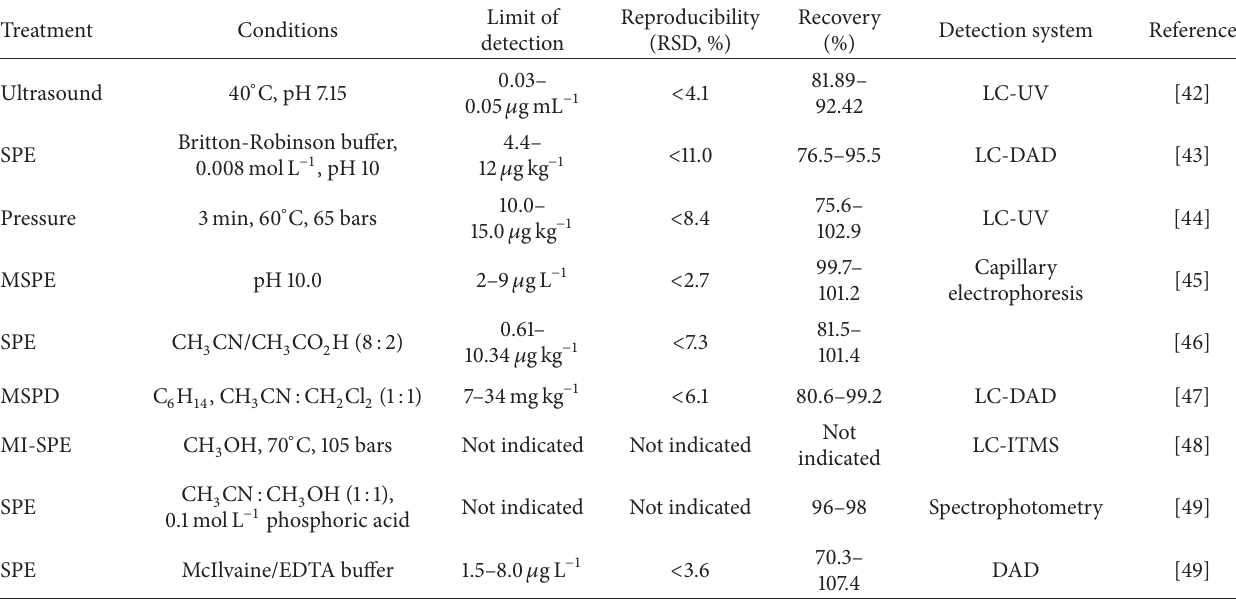
Table 4: Proficiency parameters for sample pretreatment methods